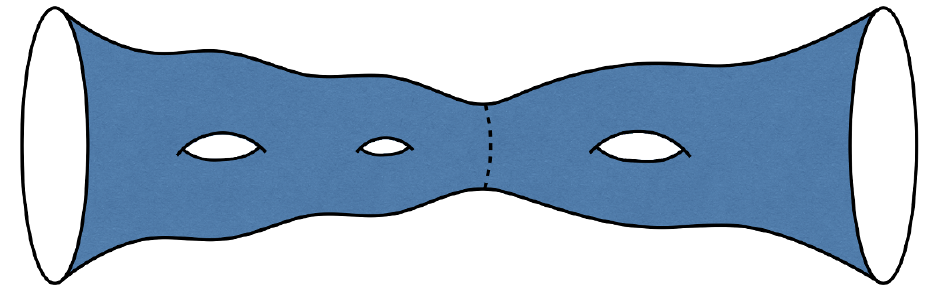
Figure 20 . A cartoon of the 3-handled wormhole, with a candidate minimal extremal surface drawn in dashed